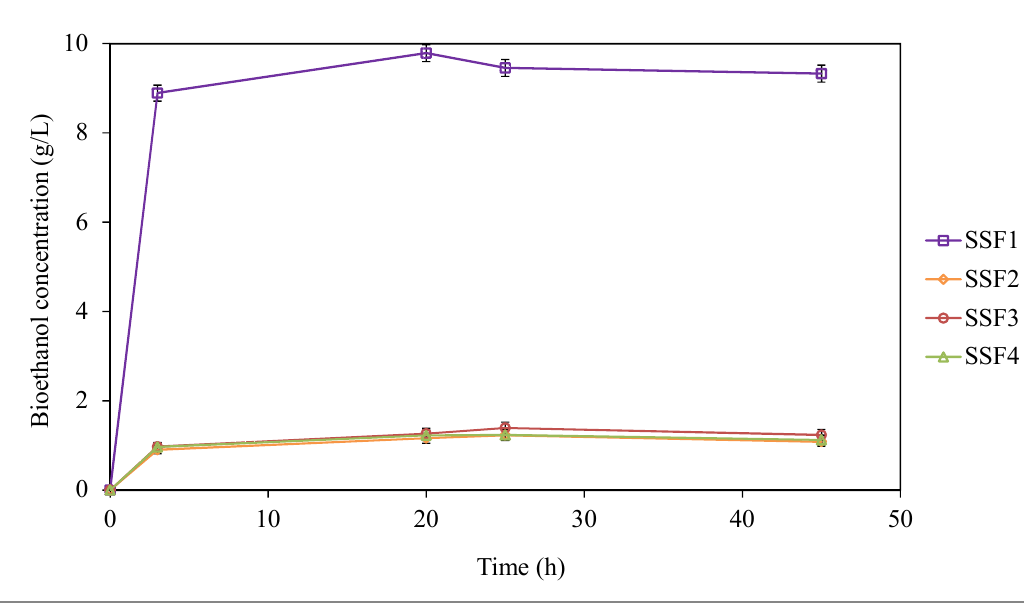
Figure 2. Time course of bioethanol concentration in the SSF experiments (carried out at LSR of 12 g/g and ESR of 1 U/g, with 5 mL of nutrients and 10 mL of yeast inoculum) using SSS samples and solid phases from selected pretreatments (see Table 3 for nomenclature).